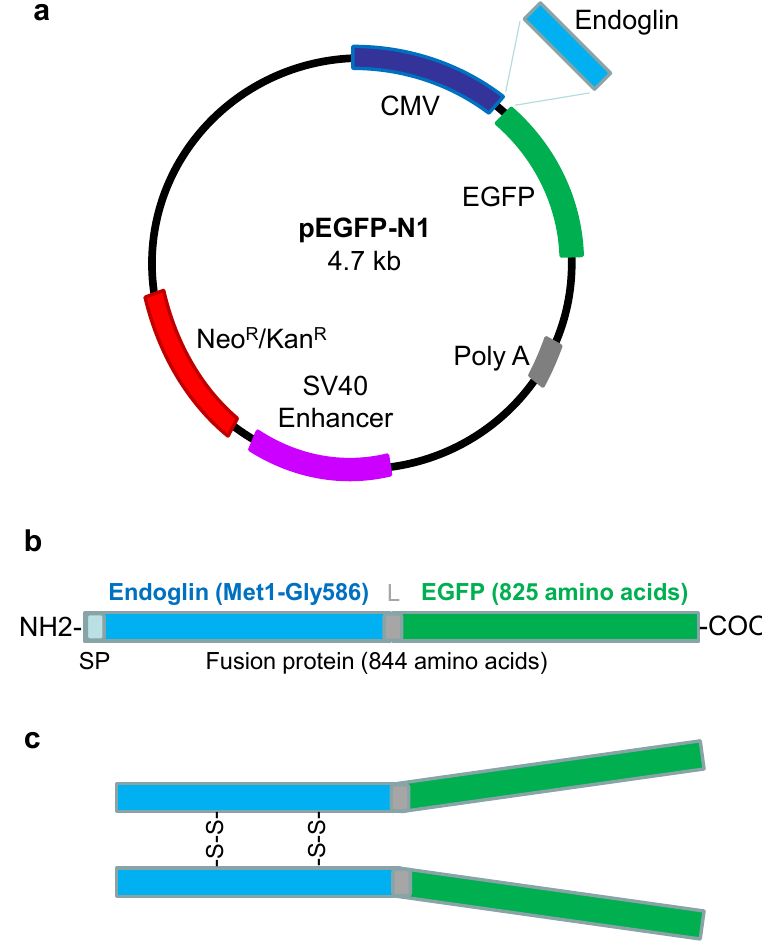
Figure 1. Generation of expression vector encoding endoglin–GFP fusion protein. ( a ) Schematic representation of pEGFP–N1 expression vector containing a cytomegalovirus promoter, the neomycin/kanamycin resistance gene, an SV40 enhancer, and a polyA sequence. Human endoglin cDNA (Met1-Gly586) was inserted into the multicloning site upstream of EGFP cDNA. ( b ) Schematic representation of predicted primary structure of the fusion protein. Relative positions of endoglin (amino terminus), a small linker (L), and EGFP (carboxy terminus) sequences within the fusion protein that contains a total of 844 amino acids are indicated. SP, Signal peptide. ( c ) Schematic repre- sentation of predicted fusion protein upon secretion. Presence of endoglin disulfide linkages (S-S) leading to a dimeric protein is indicated. Potential glycosylation sites were omitted for simplification. Drawings are not to